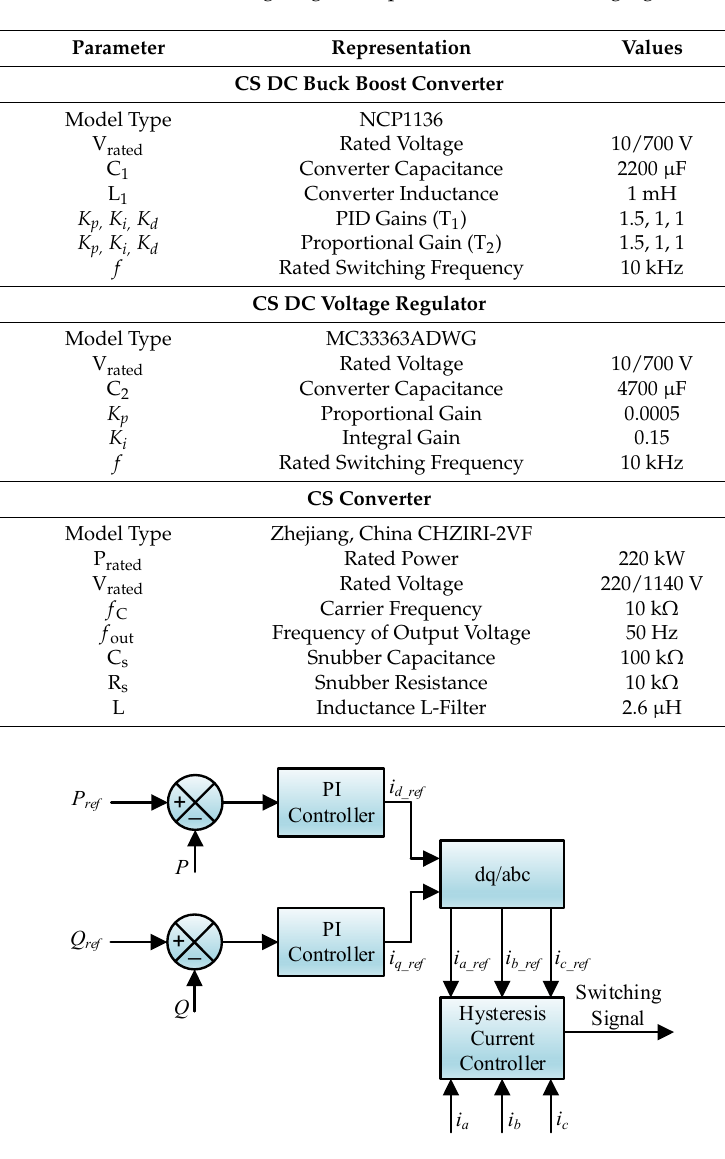
Table 3. Buck boost/voltage regulator parameters of the charging station.